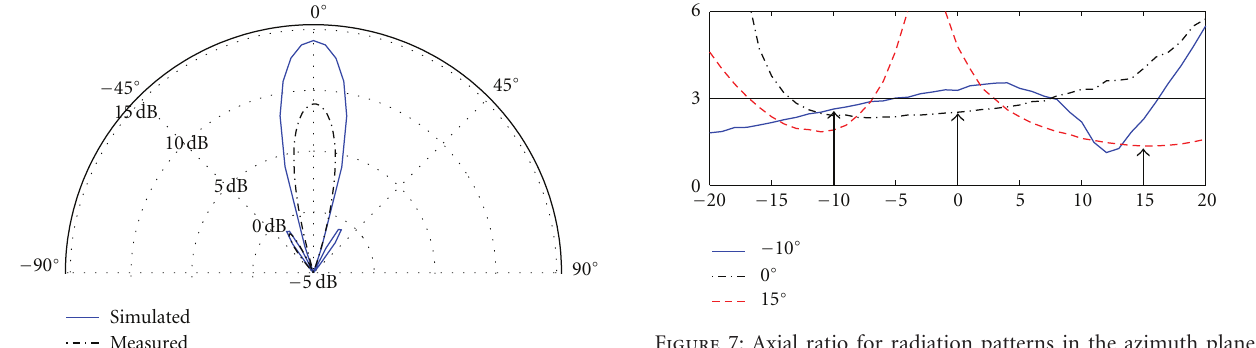
Figure 7: Axial ratio for radiation patterns in the azimuth plane with direction of maximal gain at − 10 ◦ , 0 ◦ , and 15 ◦ .